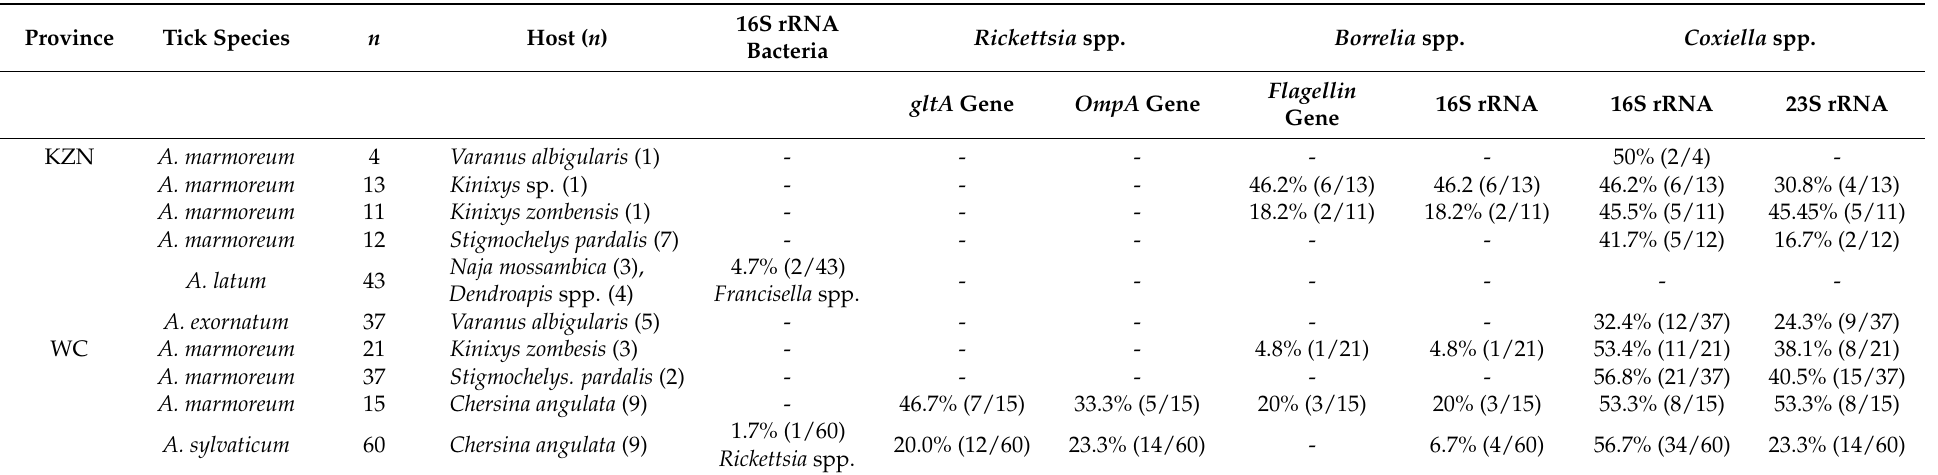
Table 2. Prevalence of bacterial microorganisms from reptilian Amblyomma